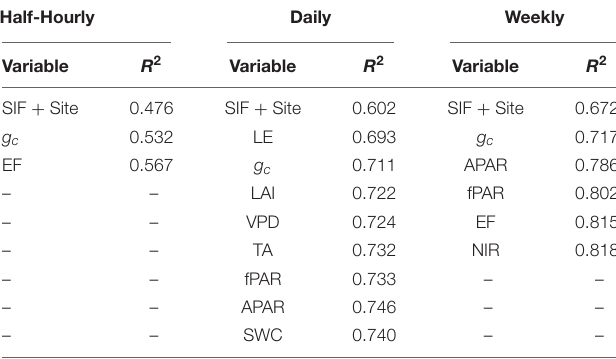
TABLE 4 | Effects of environmental variables on the goodness-of-fit of LME of GPP vs. SIF using forward stepwise regression.